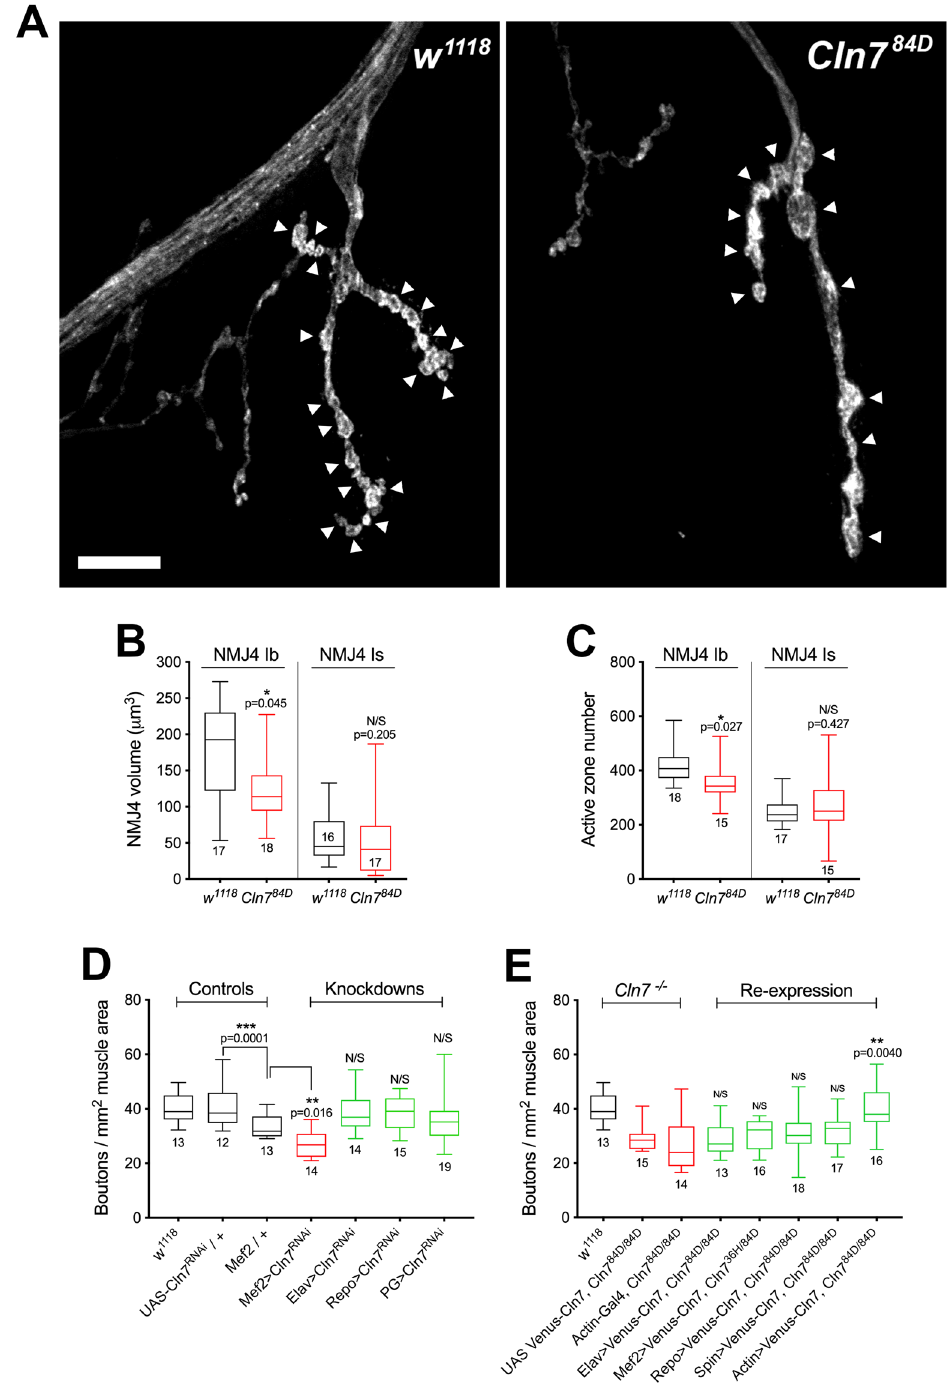
Figure 3. Loss of Cln7 leads to neurodevelopmental defects. ( A ) Anti-HRP staining of the late larval NMJ of w 1118 control and Cln7 84D flies to visualize the neuronal membrane. Swellings of the pre-synaptic membrane (boutons) are indicated with arrowheads. There are fewer boutons in Cln7 84D larvae but these are occasionally swollen. Scale bar = 10 μ m. ( B ) The volume of type Ib (I big) junction is reduced in Cln7 84D flies but the type Is (I small) junction is unchanged. ( C ) Active zones number is reduced in Cln7 84D type Ib but not in type Is junctions. ( B,C ) 2-tailed t-tests, n is indicated). ( D ) The number of boutons can be used as a proxy for junction size. Type Ib junctions are smaller when Cln7 expression is knocked down post-synaptically in muscle (Mef2- gal4) but not with pre-synaptic (Elav), pan-glial (Repo) or perineurial glial knockdown (PG). ( E ) Normal NMJ development is restored only when Cln7 is re-expressed ubiquitously (actin-Gal4) in the mutant background. ( D,E ) ANOVA with Dunnett’s post-hoc comparisons, n is